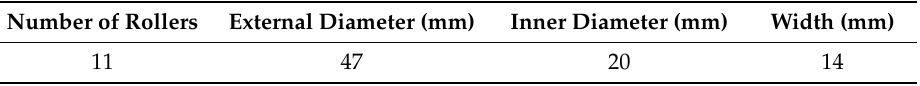
Table 1. Structure parameters of roller bearing.